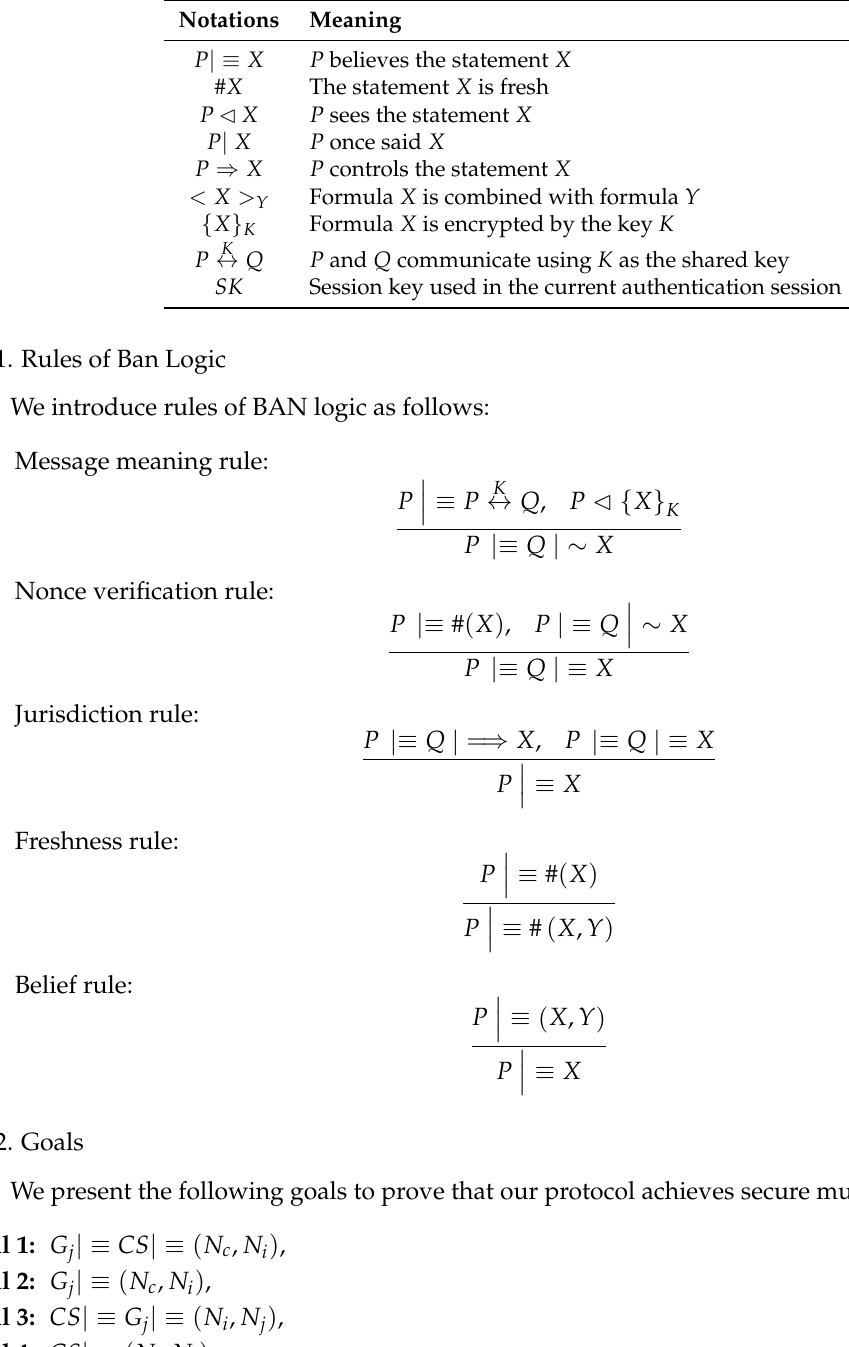
Table 3. Notations of Burrows–Abadi–Needham (BAN)